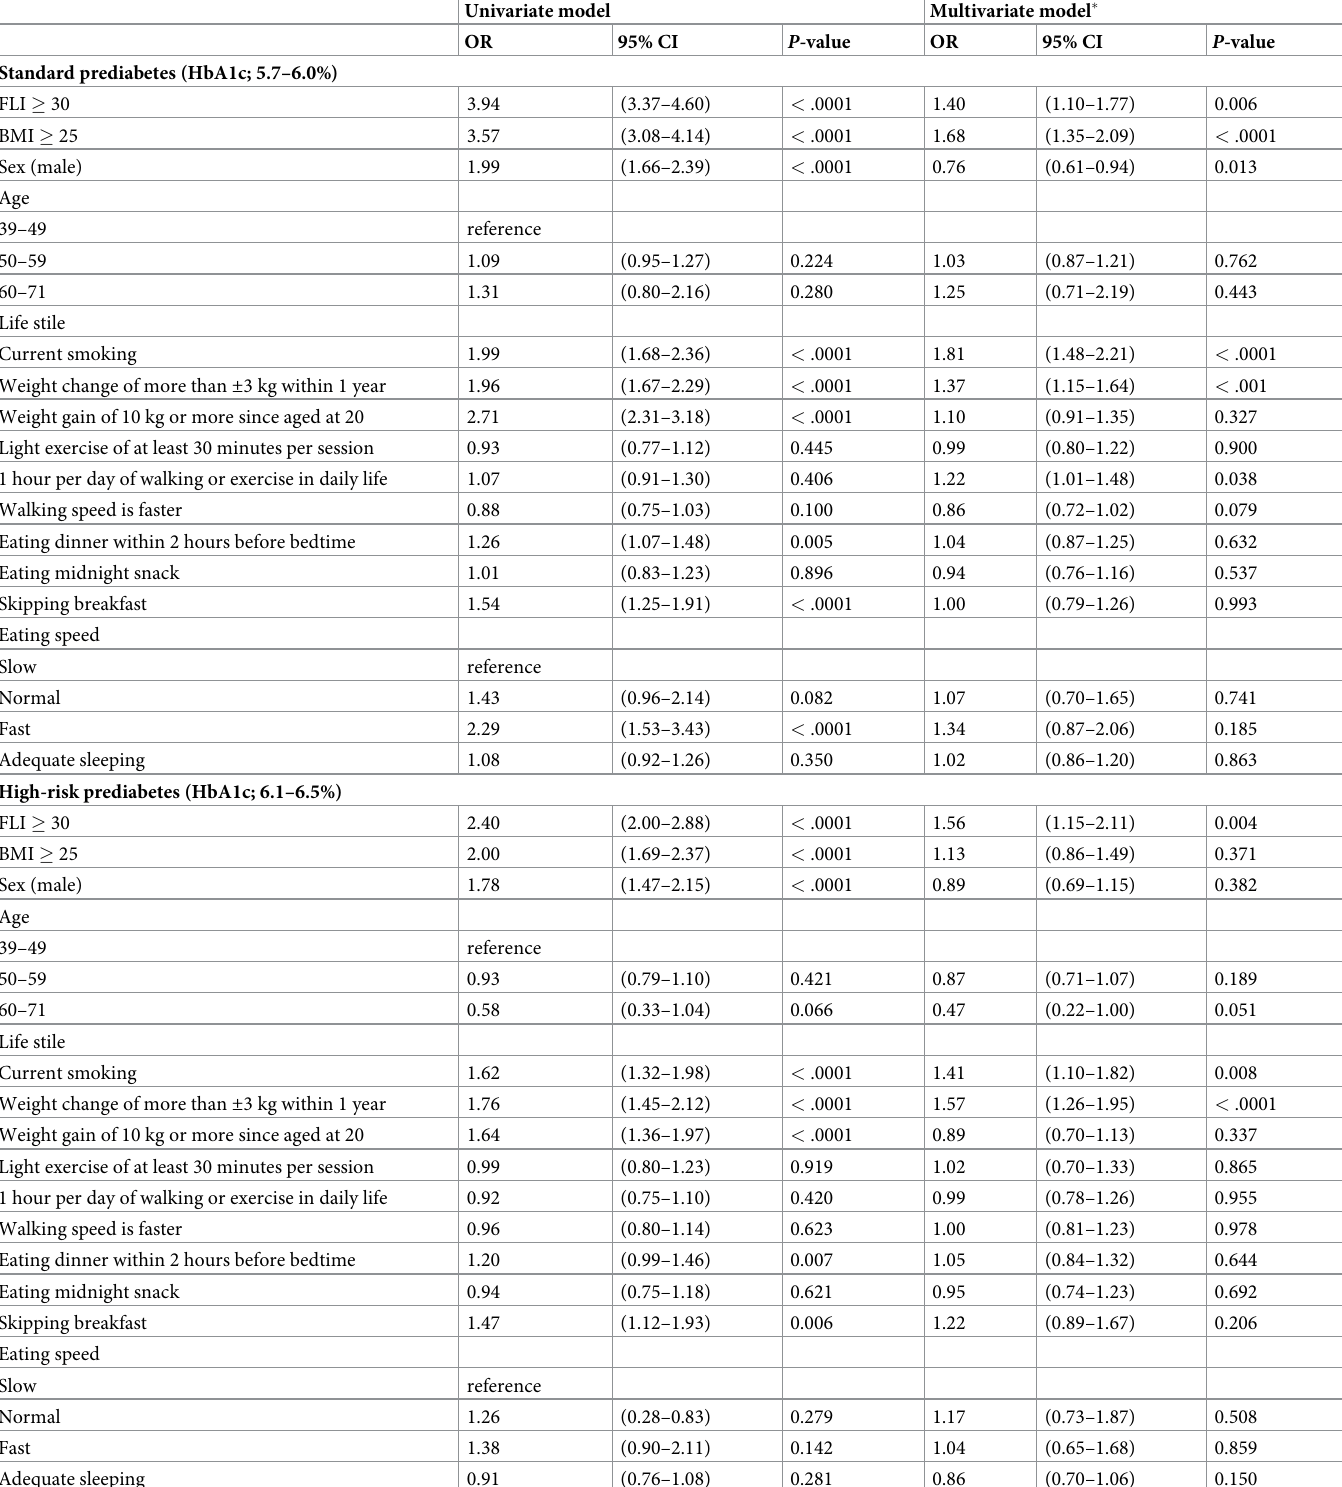
Table 2. Univariate and multivariate adjusted logistic regression models for the incidence of new-onset